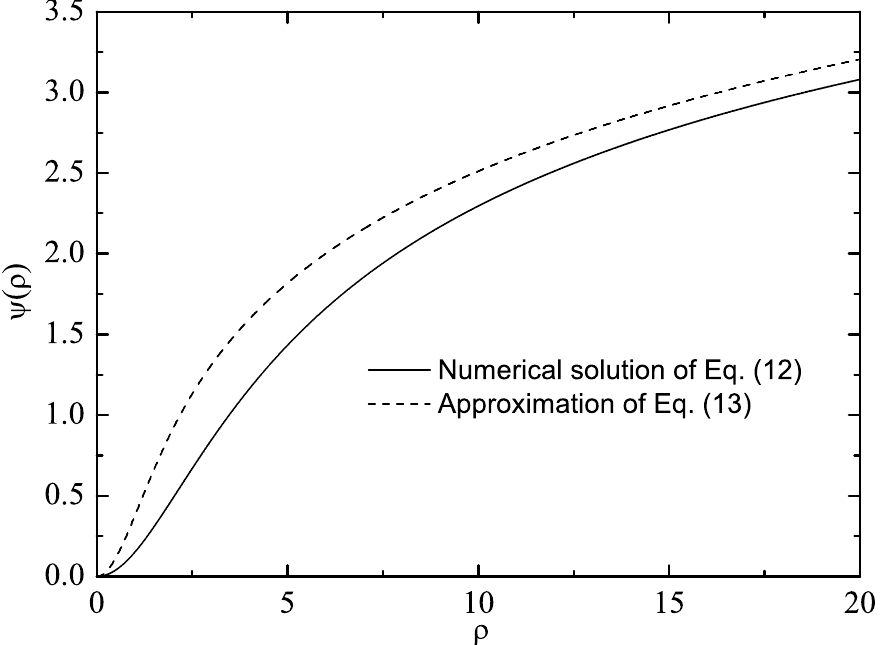
Figure 1. Scaled extra scalar potential for a point source (solid line) vs. the approximation in Equation (13) (dashed